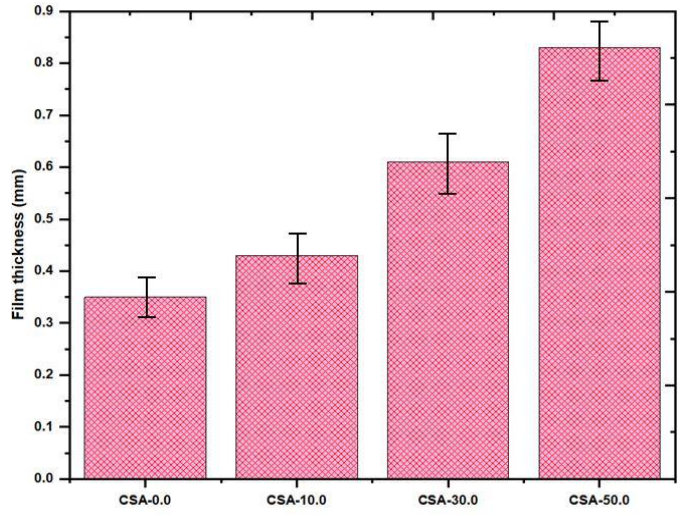
Figure 5. Film thickness versus film type. Error bars: ±2.05 SD .